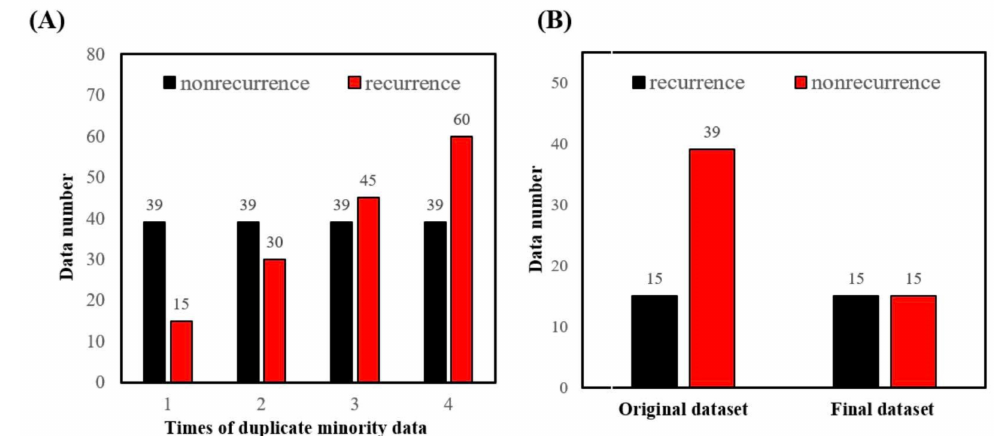
Figure 3. ( A ) Strategy 1: Random over-sampling replicated the smaller set (red) and kept the larger set (black). The duplication time was 1, 2, 3, and 4 (as depicted in the x-axis). ( B ) Strategy 2: Random under-sampling disregarded some data in the larger set (red) and kept the smaller set (black). The second strategy was to randomly choose the data (for both training and test sets) using recurrence and non-recurrence with a fixed ratio (1:1); the remaining patient data was discarded. This strategy was similar to the under-sampling technique [17]. An example is shown in Figure